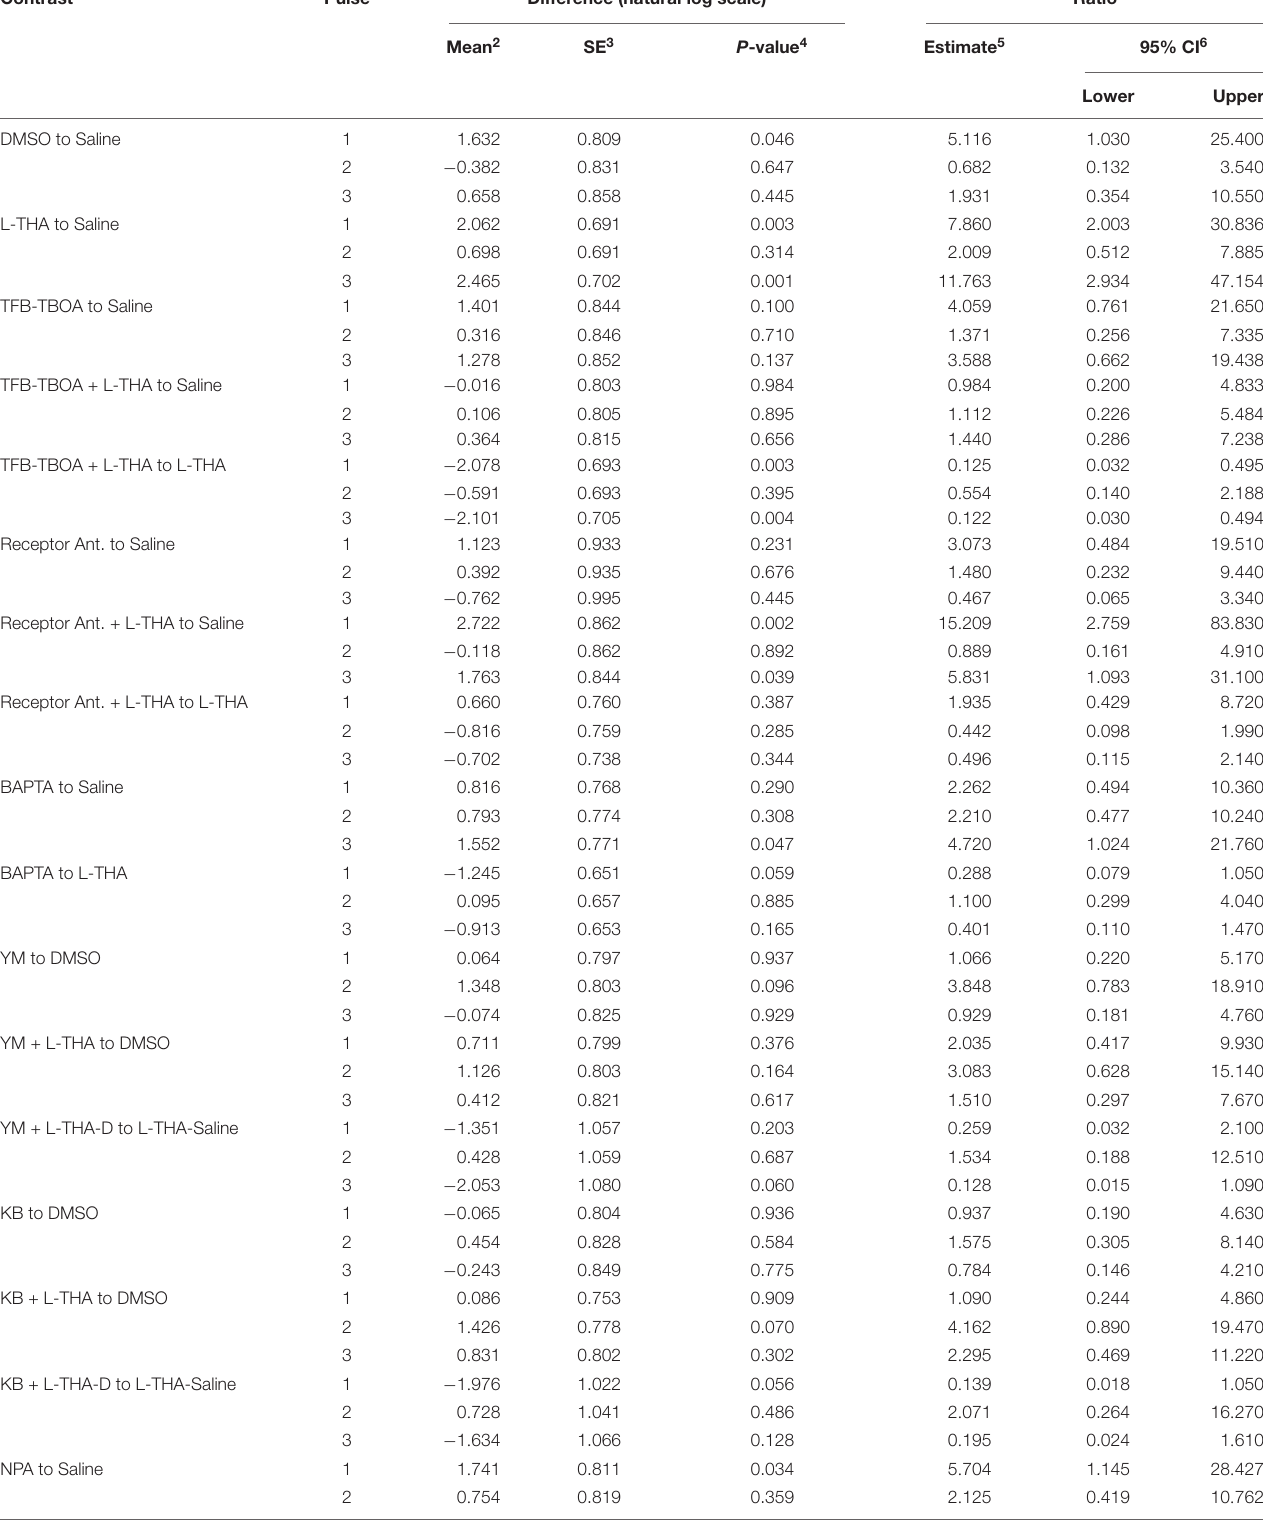
TABLE 2 | Individual pulses – Area under the curve 1 . Contrast